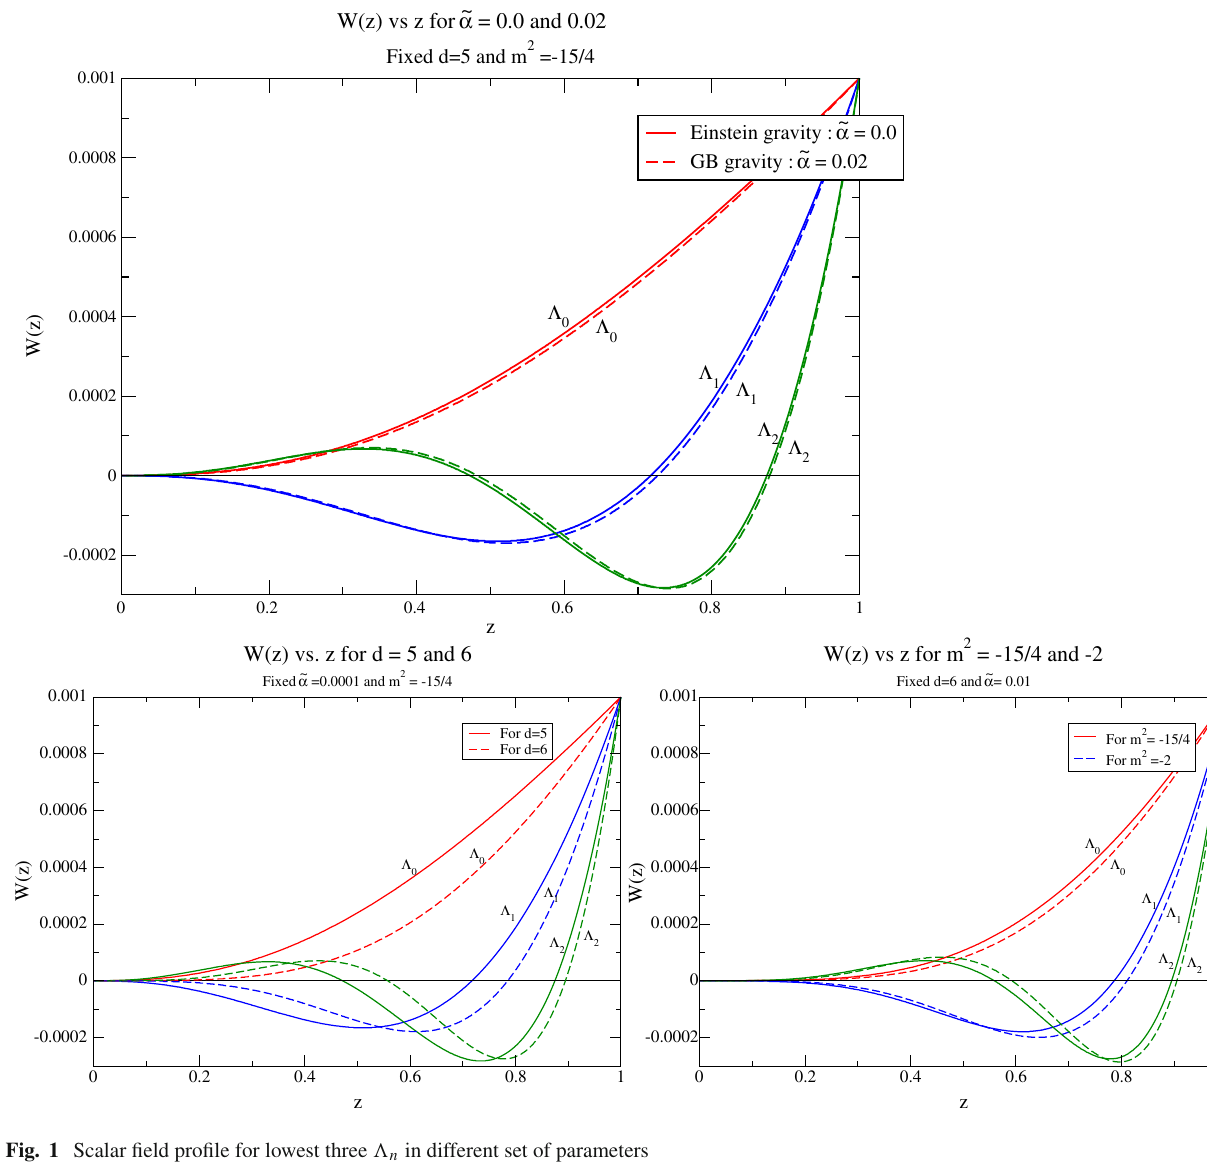
Fig. 1 Scalar field profile for lowest three (cid:2) n in different set of